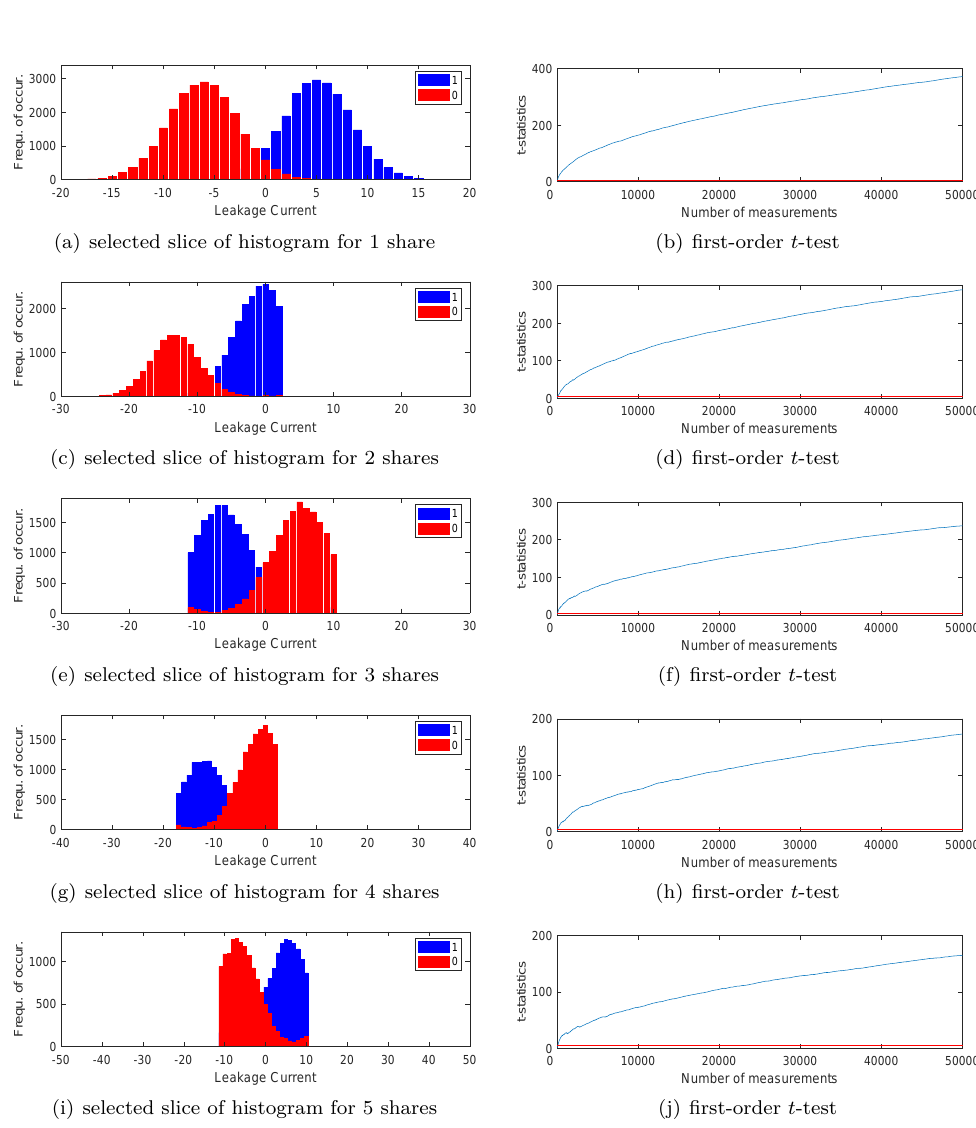
Figure 20: Same experiments as in Figure 10, but without stopping the clock and instead running an LFSR-based PRNG during the